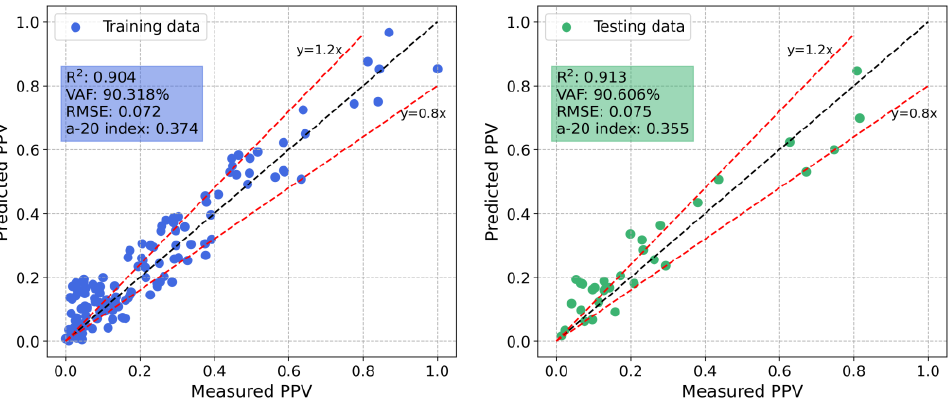
Figure 7. Predicted PPV values by the neuro-swam model VS measured ones.